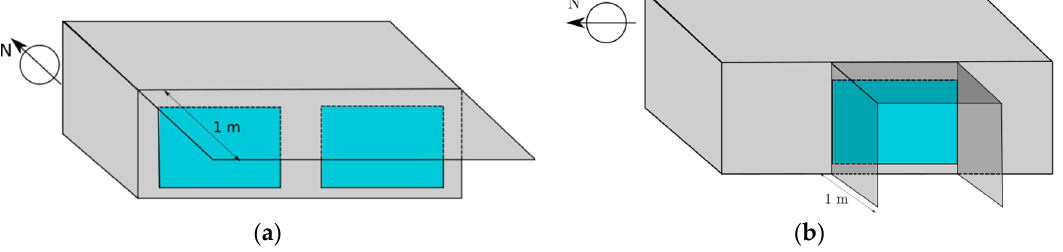
Figure 5. Horizontal shading device for cases 610 and 910 ( a ); vertical and horizontal shading devices for cases 630 and 930 ( b ).